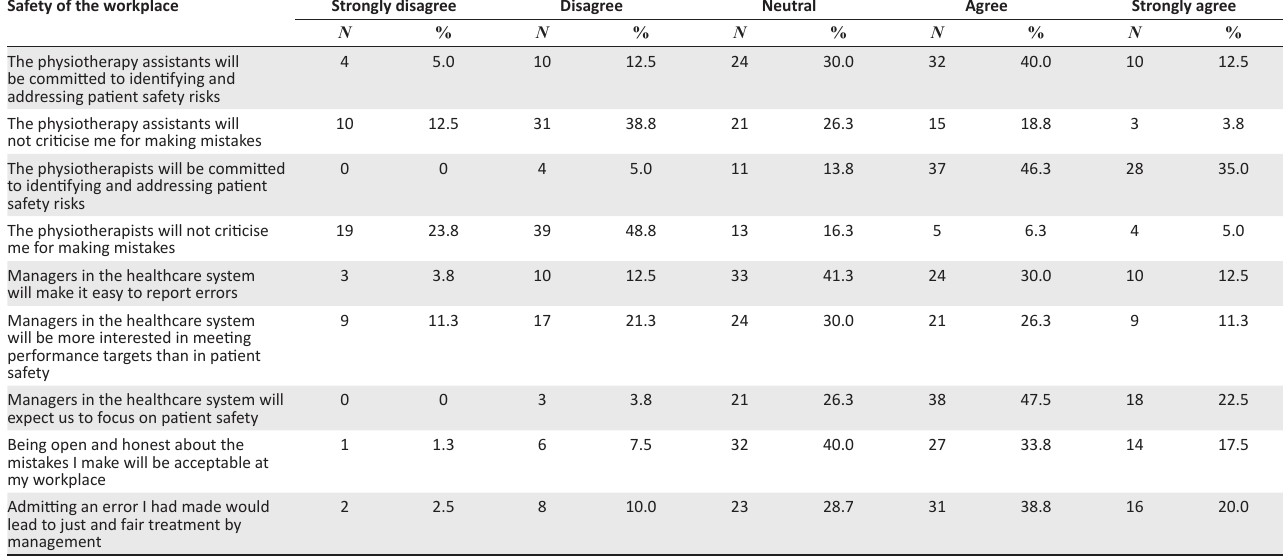
TABLE 3: Safety of the workplace ( n = 80).